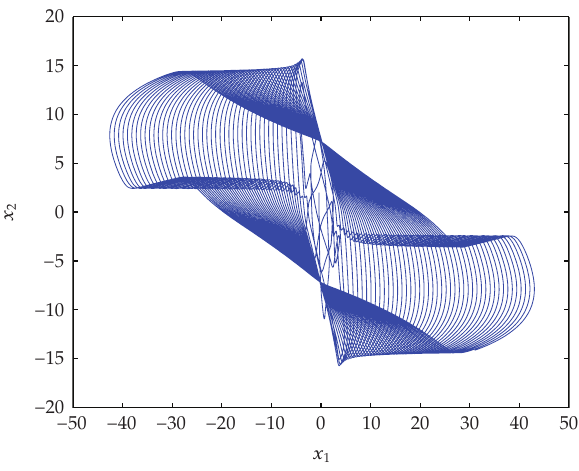
Figure 1: State responses of x 1 (cid:2) t (cid:3) and x 2 (cid:2) t (cid:3)